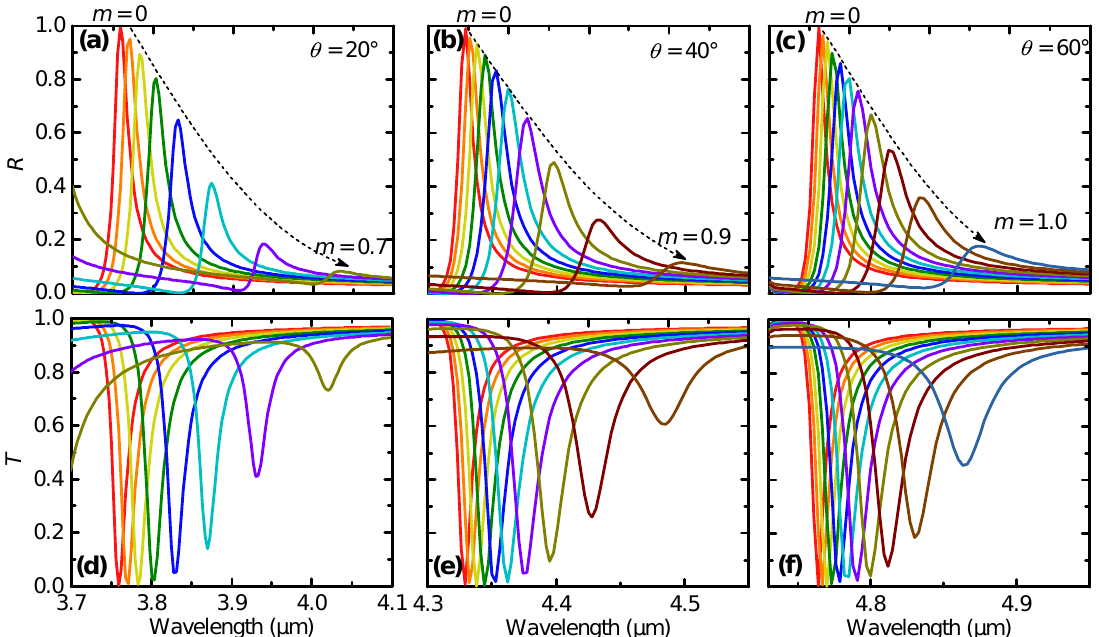
Figure 7. Simulated ( a – c ) reflection and ( d – f ) transmission spectra of the GST metasurface with different GST crystallization fractions varying from m = 0 to a certain value when the reflection peak become less pronounced. The calculations were performed under TE-polarized incidence at three typical different oblique incidence angles, ( a , d ) θ = 20 ◦ , ( b , e ) θ = 40 ◦ , and ( c , f ) θ = 60 ◦